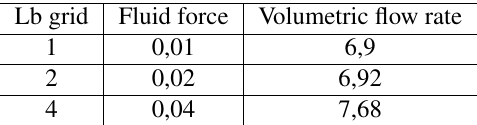
Table 2. Testing di ff erent LBgrid values with di ff erent fluid